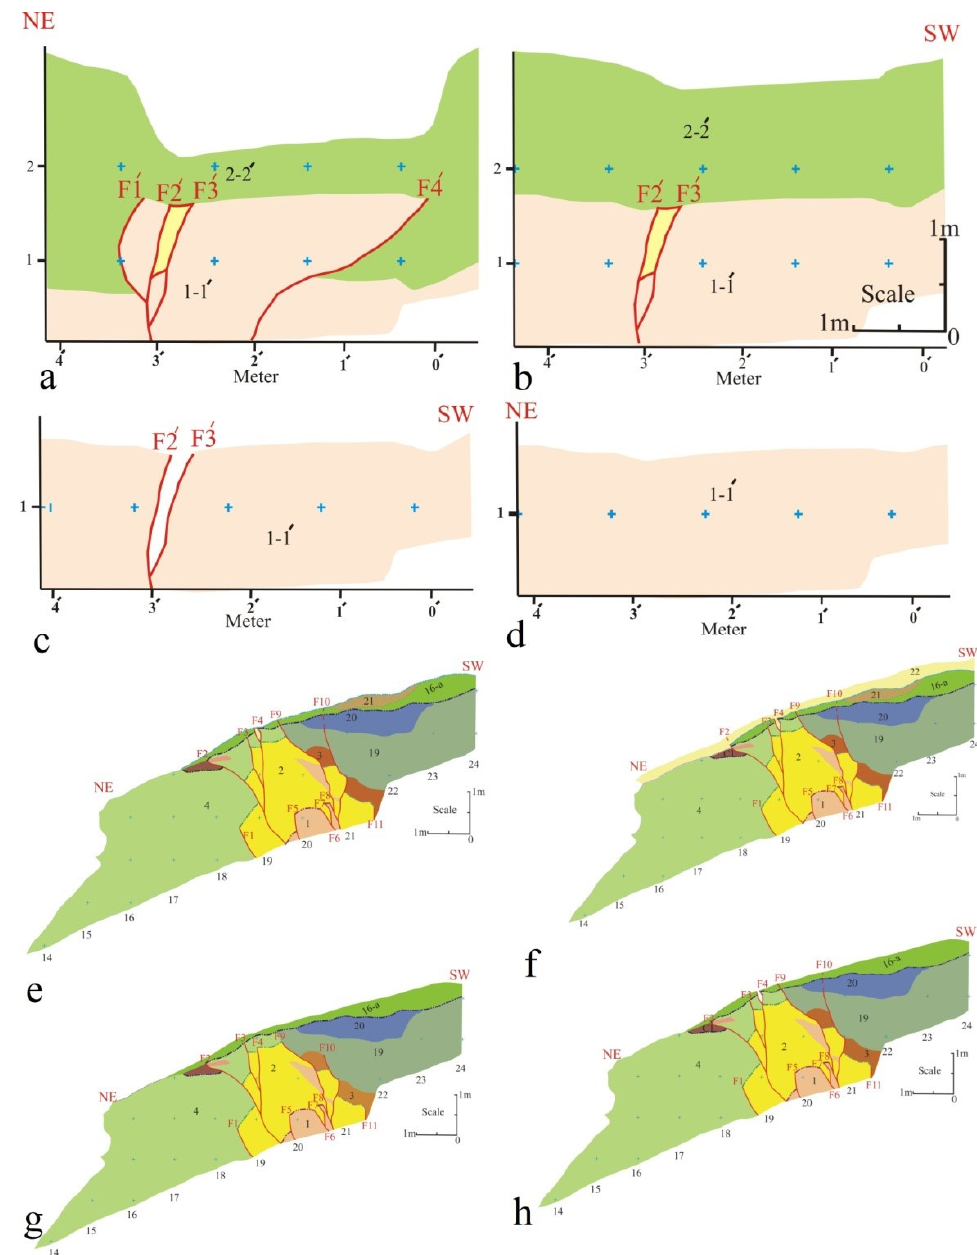
Figure 13. The back stripping scenario on the eastern wall of the trench (TC). The scenario confirms the seismic deformation of the events Ev1 to Ev4 by Doroud Fault activity. The red lines are faults. ( a ) Pre-event 1 and the after-deposit unit 2 ′ . ( b ) Post-event 1 associated with cutting unit 2. ( c ) Pre-event 2. ( d ) Post-event 2 is associate with fissure-filled unit. ( e ) Pre-event 3. ( f ) Post-event 3 possibility associated with cutting unit 23. ( g ) Pre-event 4. ( h ) Post-event 4 associated with fissure-filled unit 23.